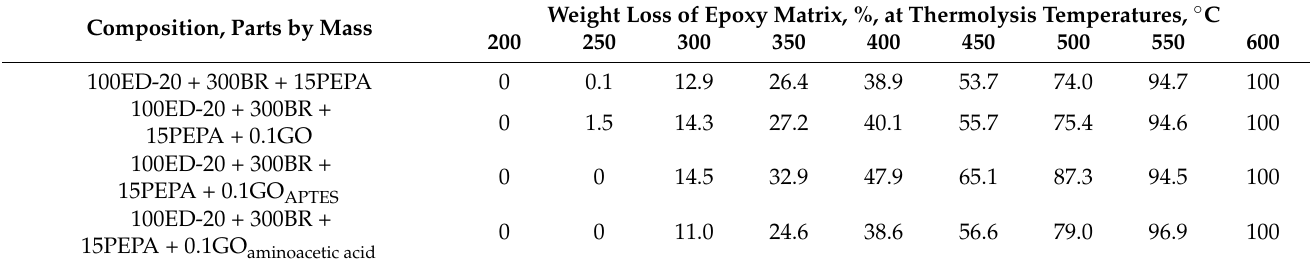
Table 4. Thermogravimetric analysis results.